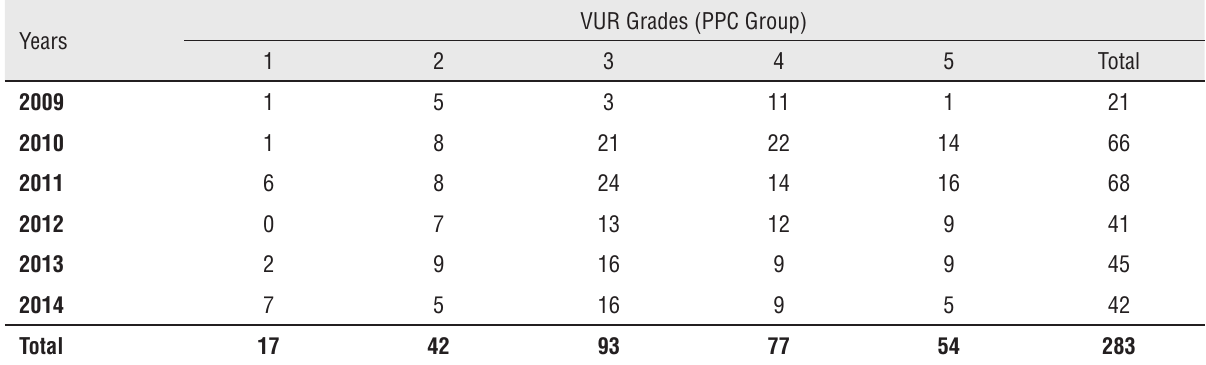
Table 2 - vUR grade distribution through the years in PPC group.